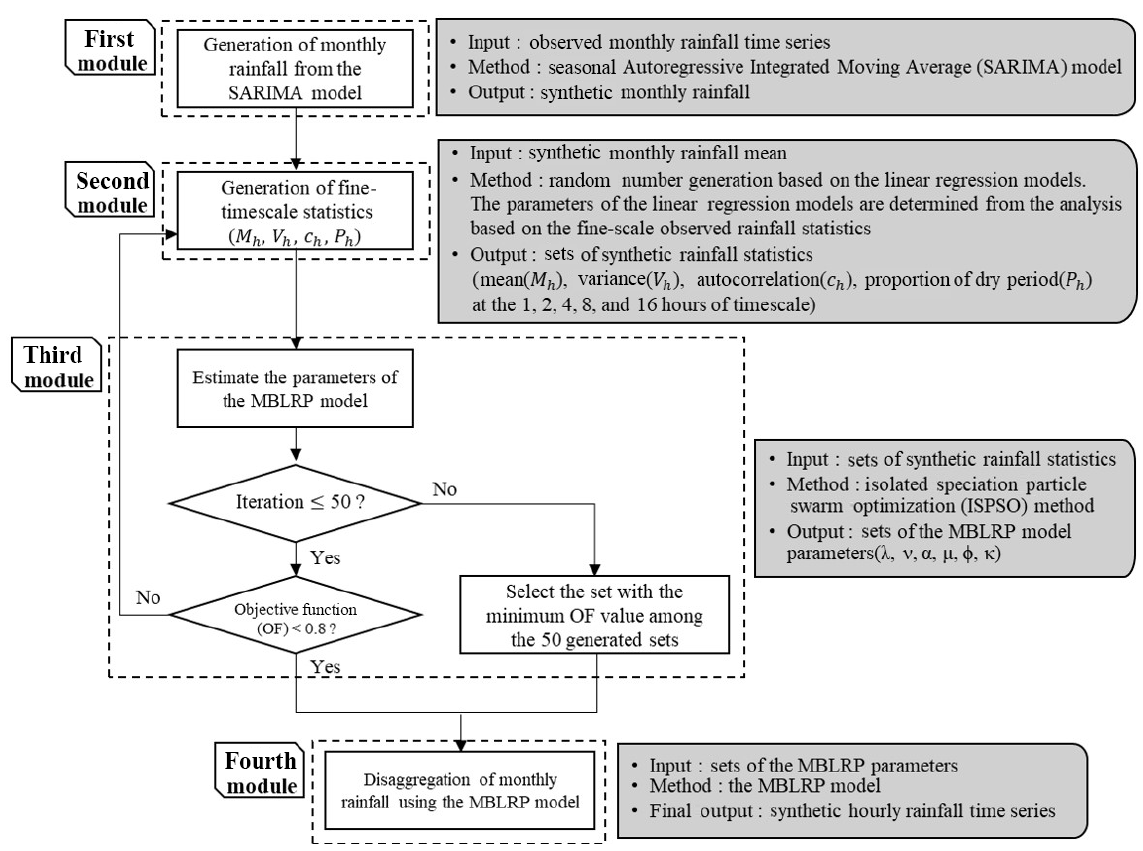
Figure 4. The four different modules of the model of this